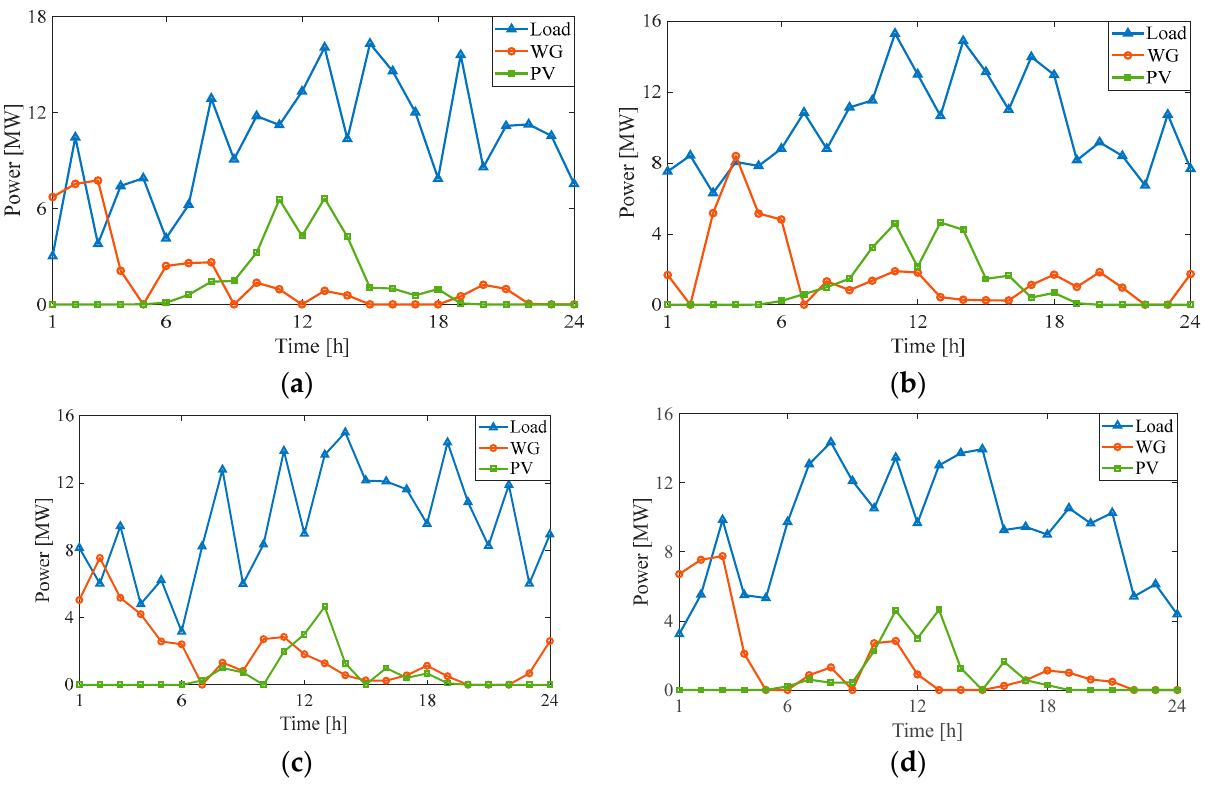
Figure 6. Distribution network under typical scenarios: ( a ) Scenario1; ( b ) Scenario2; ( c ) Scenario3; ( d ) Scenario4.